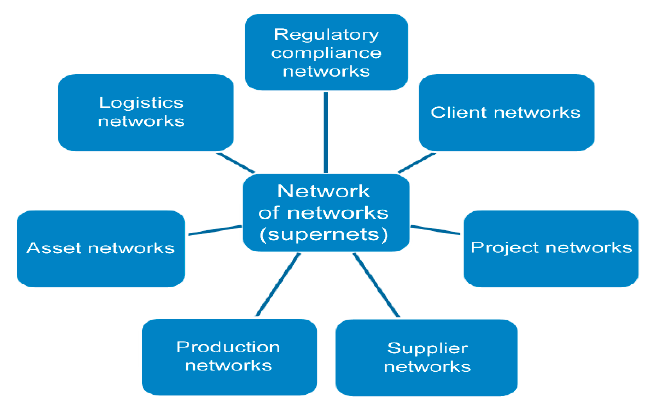
Figure 2. Super network composition and topology.